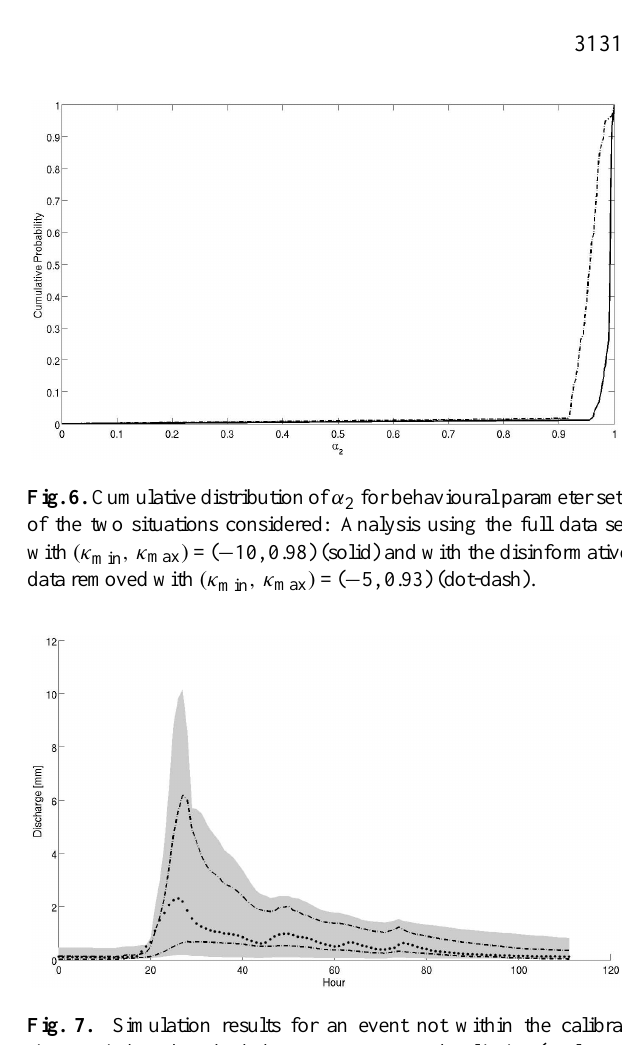
Fig. 7. Simulation results for an event not within the calibra- tion period. the shaded area represents the limits (evaluated on a time step by time step basis) of the simulations deemed to be behavioural when calibrated against all the calibration data with (κ min , κ max ) =( − 10,0.98). The lines correspond to the limits when on the informative calibration data is used and (κ min , κ max ) =( − 5, 0.93).Points represent the observed